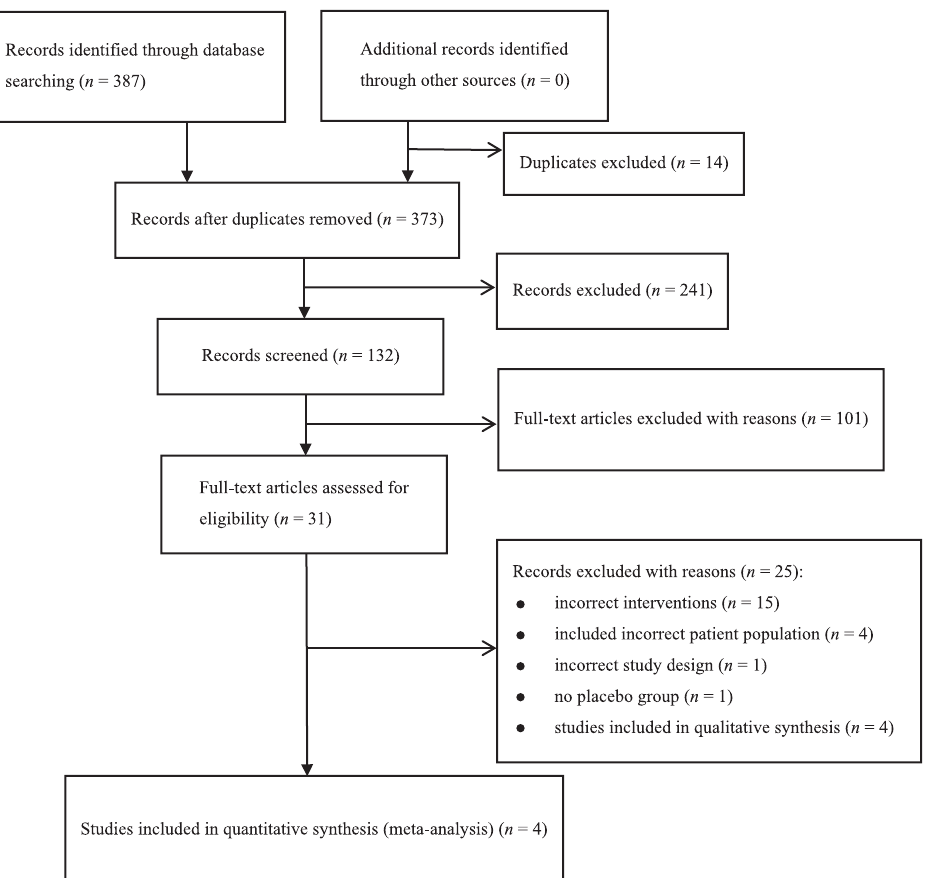
Figure 1. Literature screening